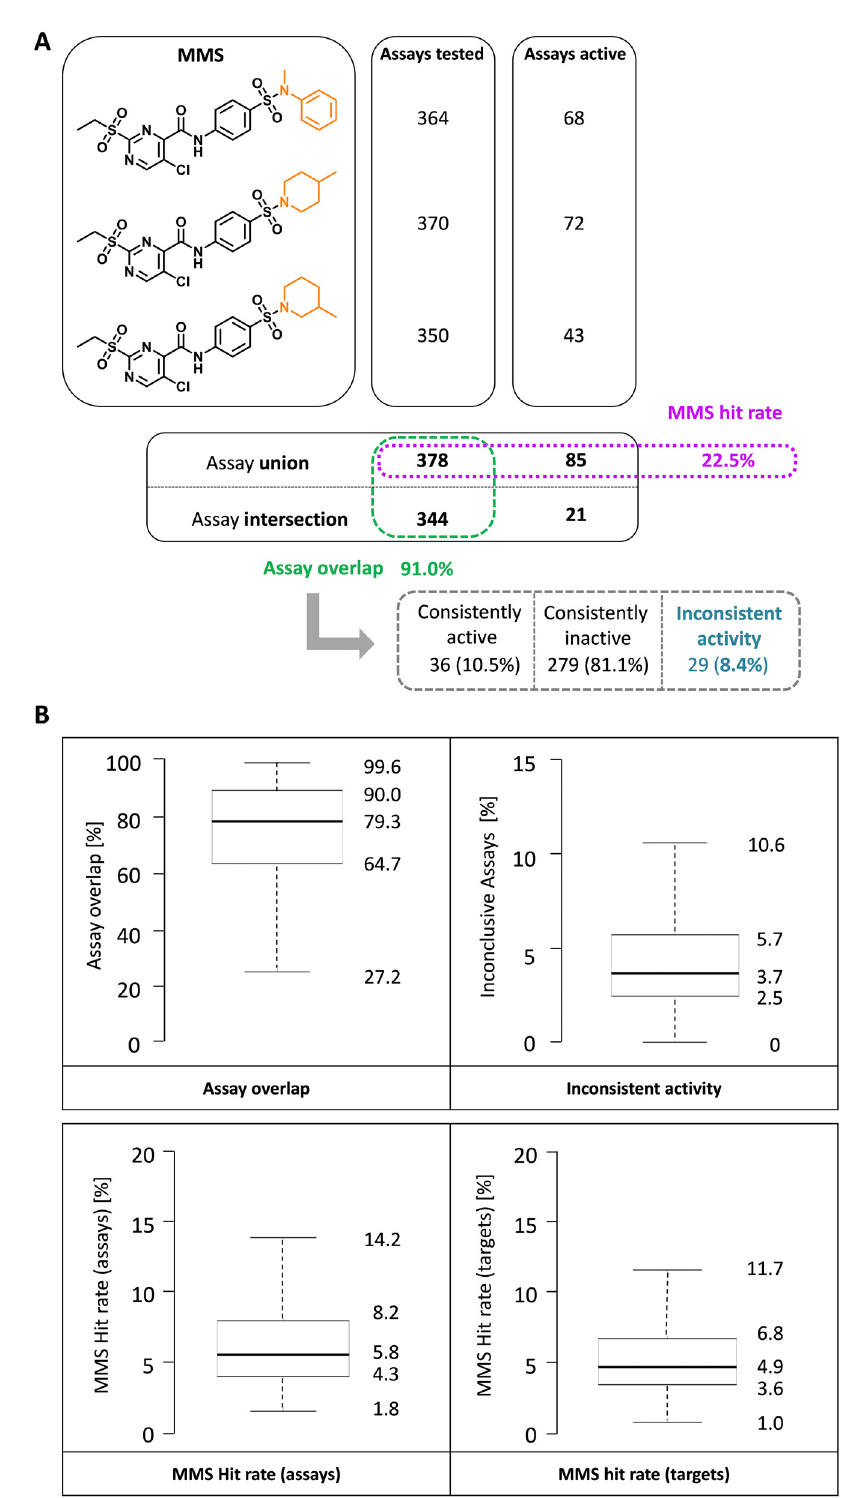
Figure 3. Characterization of matched molecular series (MMSs). ( a ) An exemplary MMS comprising three analogs is shown. The MMS core and varying substituents are colored in black and orange, respectively. For each compound, the number of assays it was tested and active in is reported, respectively. Furthermore, the assay union, intersection, and MMS hit rate (purple) are given. From these data, the assay overlap (green) of MMS analogs was determined as well as the proportion of assays with consistent activity, inactivity, and inconsistent activity (blue). ( b ) Boxplots are shown reporting the distribution of assay overlap, assays with inconsistent activity as well as assay- or target-based MMS hit rates for PubChem compounds with greater than 1.8% hit